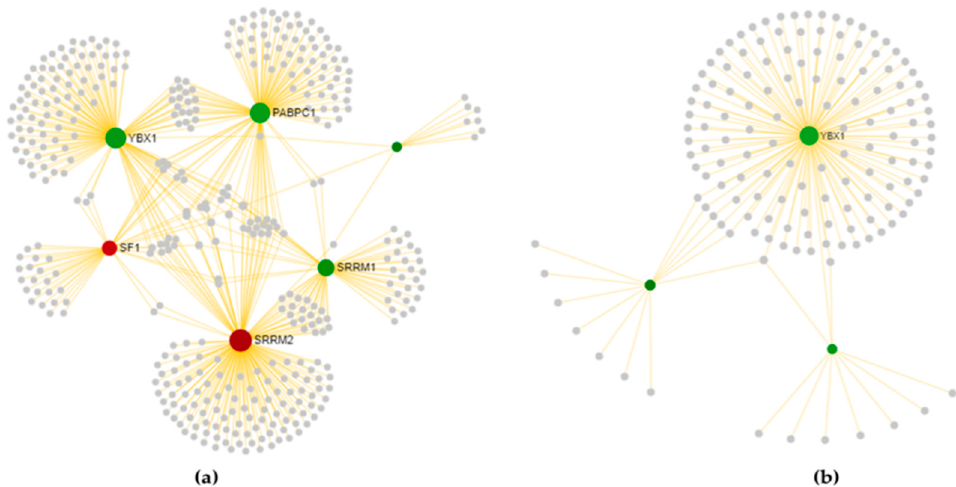
Figure 6. Spinal cord-specific protein–protein interaction (PPI) networks are shown for both ( a ) SALS1 and ( b ) SALS2. To better visualize generated networks, we used the Auto layout algorithm. Sphere size is proportional to the degree of connection, whereas the color (red for up-regulated and green for down-regulated in SALS subtypes) represents the expression logFC value. Details about node properties are listed in Supplementary Data S4.